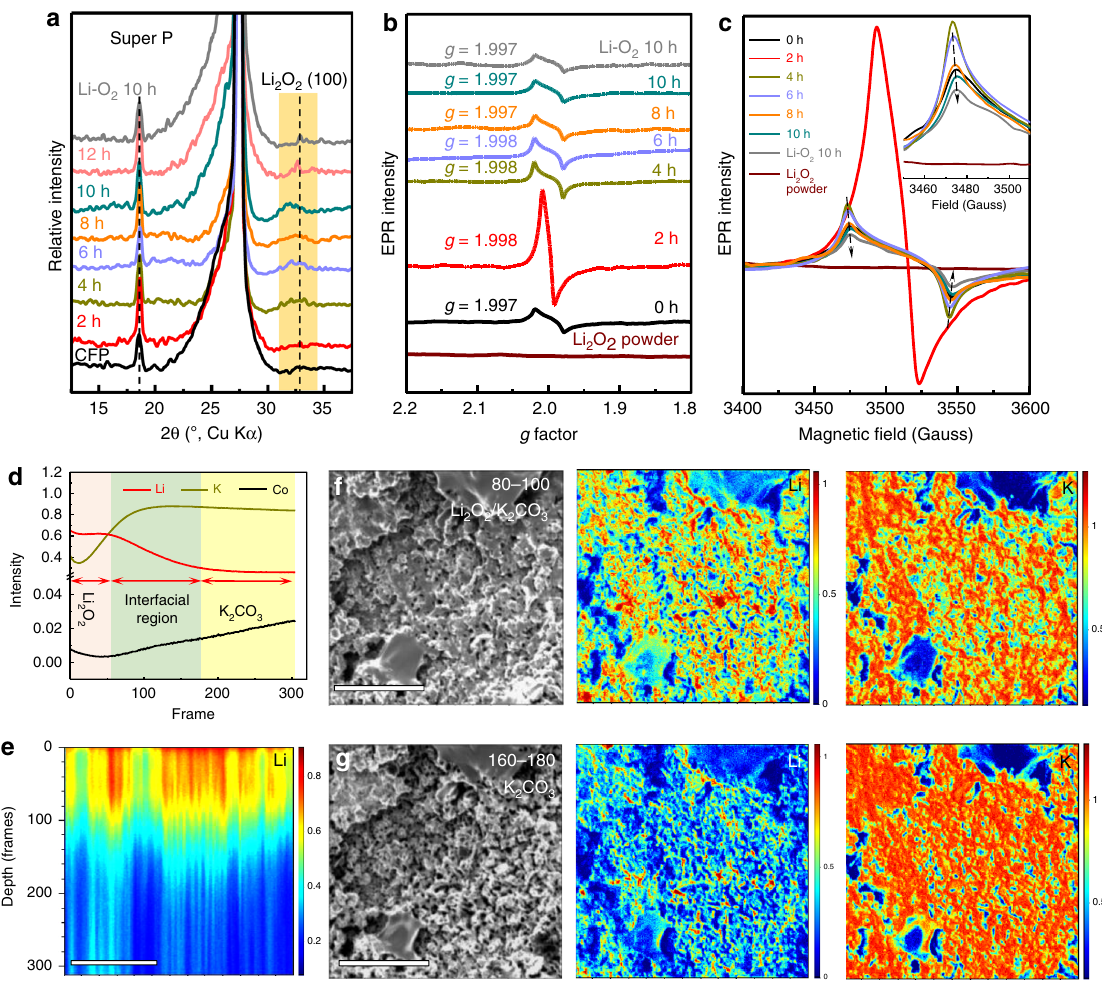
Fig. 5 Defects in Li 2 O 2 . a – c XRD patterns and electron paramagnetic resonance (EPR) spectra of conventional discharge and two-staged discharge of Super P. d Time-of- fl ight secondary ion mass spectrometric (TOF-SIMS) depth pro fi le of discharged PVP-C@LDO at stage II. e The z -distribution map of Li + on discharged PVP-C@LDO cathode at stage II. f , g TOF-SIMS mapping in the depth of 80 – 100 frames (~88 – 110 nm) and 160 – 180 frames (~176 – 200 nm). Scale bars of e – g , 10 μ